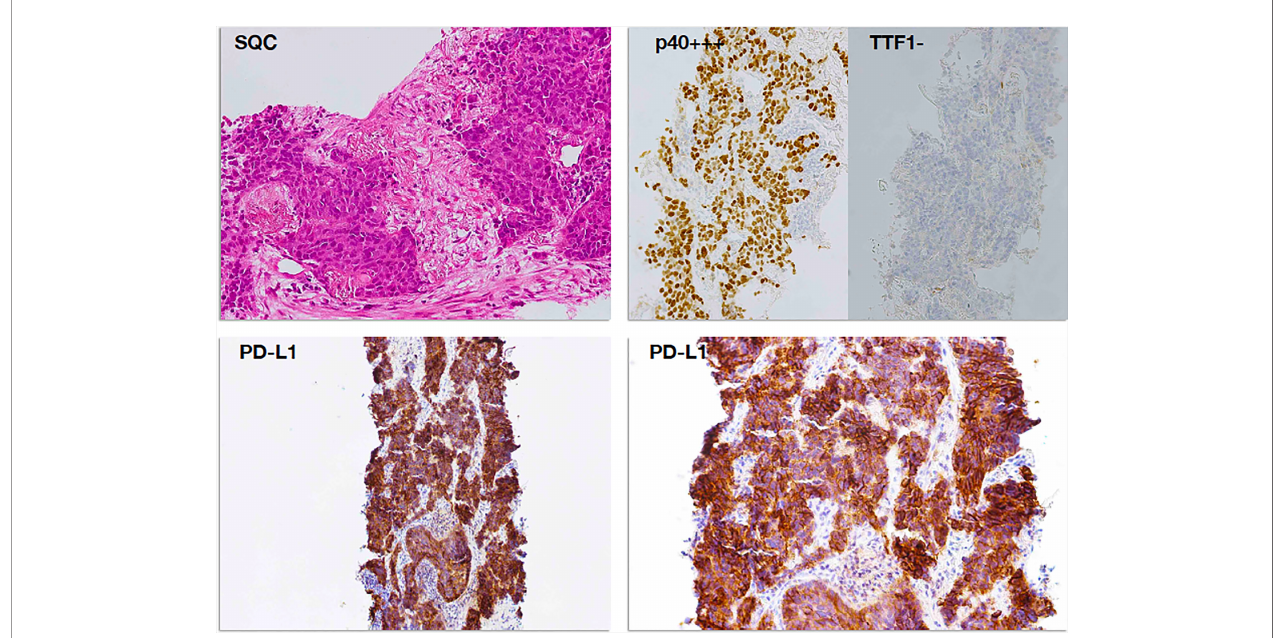
FIGURE 3 | PD-L1 immunostaining in a case of squamous cell carcinoma (SCC). Poorly differentiated squamous cell carcinoma (top left panel, H&E staining) was readily subtyped by means of immunoreactivity for p40 (p40+++) and negativity for TTF1 (TTF1 − ), according to the current WHO guidelines (top right panel). Diffuse and intense membrane immunostaining for PD-L1 was observed in tumor cells, already evident at lower magni fi cation (×100, bottom left panel) and then con fi rmed at higher magni fi cation (×200, bottom right panel) as membrane decoration in over 95% of tumor cells.